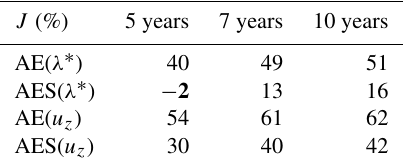
Table 3. ES approach: AE and AES for the forecast ensemble and the relative variation J of AE and AES from the update ensembles. The larger J , the more effective is the assimilation approach on the parameter or state ensembles indicated in column 2. Negative values are highlighted in bold.